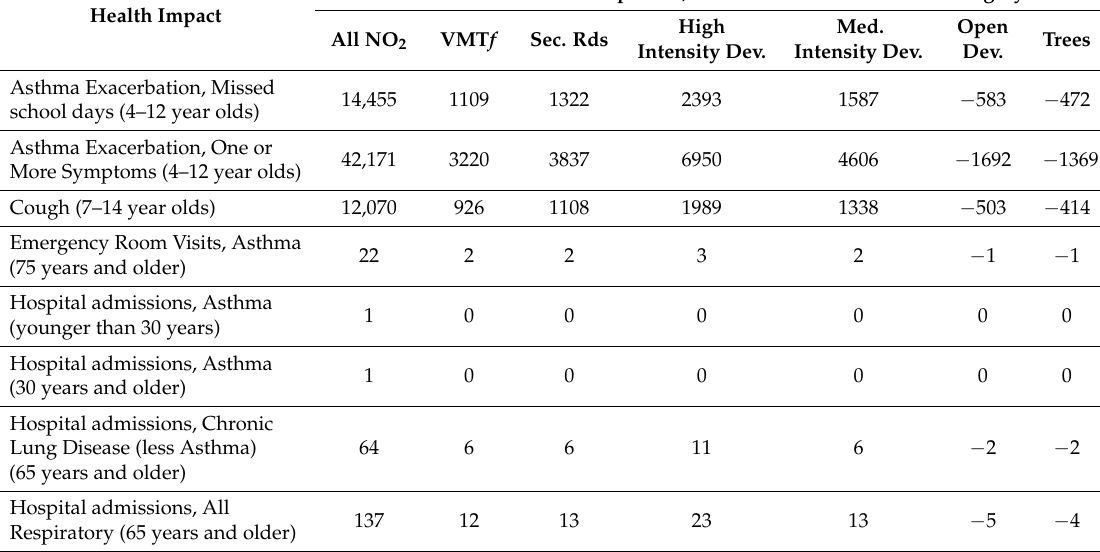
Table 4. Estimated annual incidence of respiratory problems per 100,000 individuals associated with LULC due to local influence on ambient NO 2 , in the Portland-Hillsboro-Vancouver urban